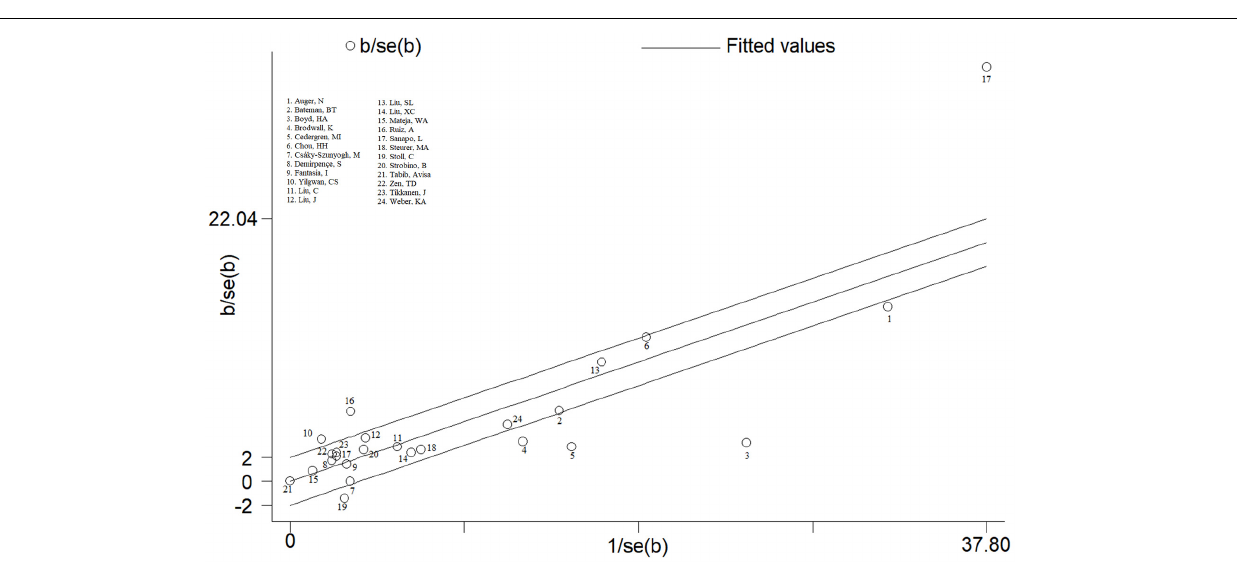
FIGURE 6 | Galbraith plots for maternal HDP exposure and CHDs risk in